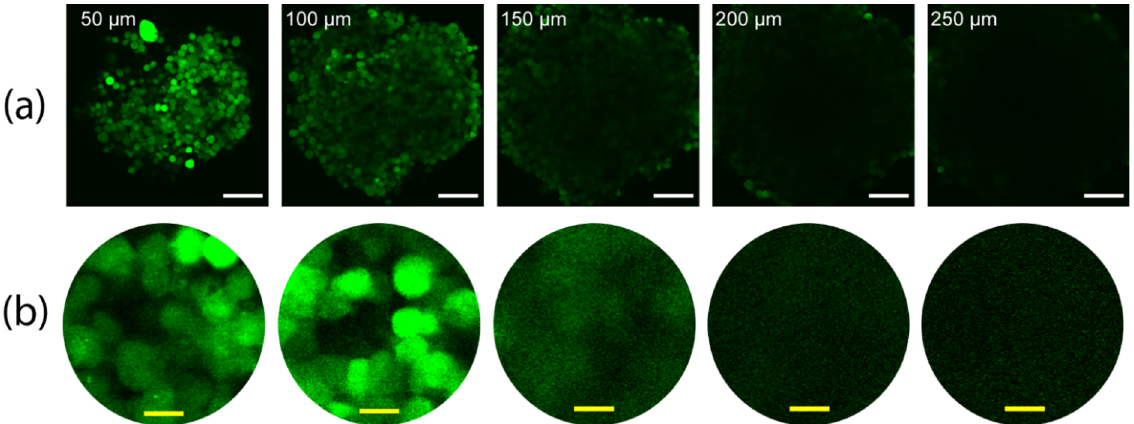
Figure 1. The gradual dimming and blurring in images of a z ‐ stack with depth, taken using two ‐ photon microscopy ( a ) z ‐ stack images of a spheroid made with EGFP ‐ positive NCI ‐ H1299 lung cancer cells. Labels show the depth of each image in the spheroid. ( b ) 5× zoomed images of the center of the images in row a and histogram ‐ adjusted for better visibility in the higher depths. White and yellow scale bars denote 100 μ m and 10 μ m, respectively.